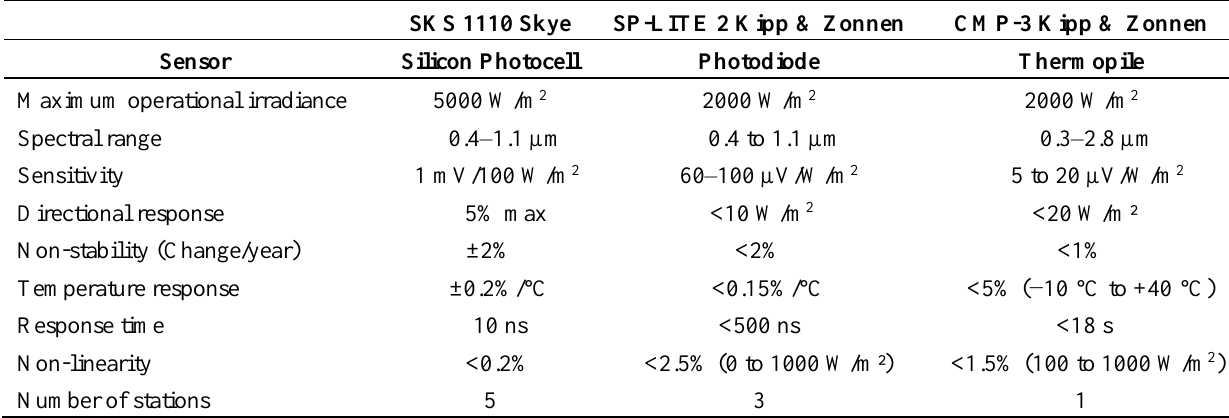
Table 3. Characteristics of the network pyranometers.